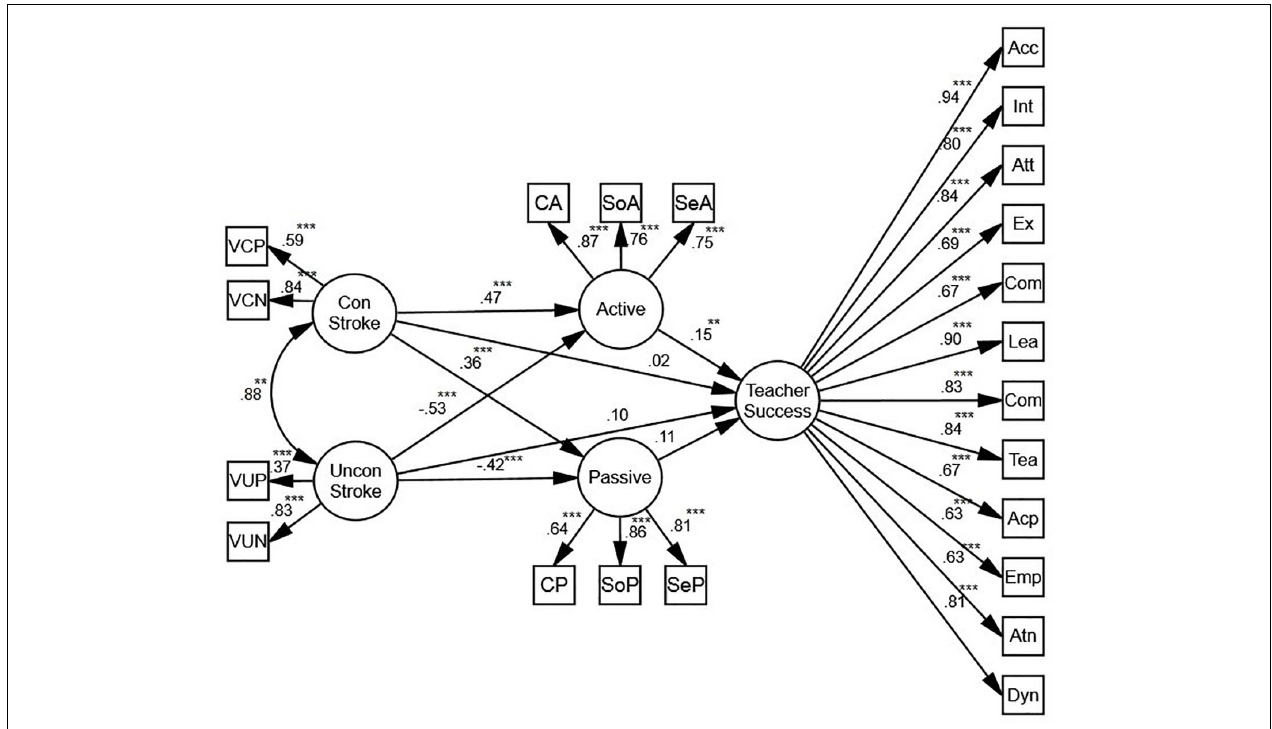
FIGURE 8 | The schematic representation of the relationships between conditional (con) and unconditional (uncon) stroke, active and passive motivation, and teacher success (** p < 0.01, *** p <